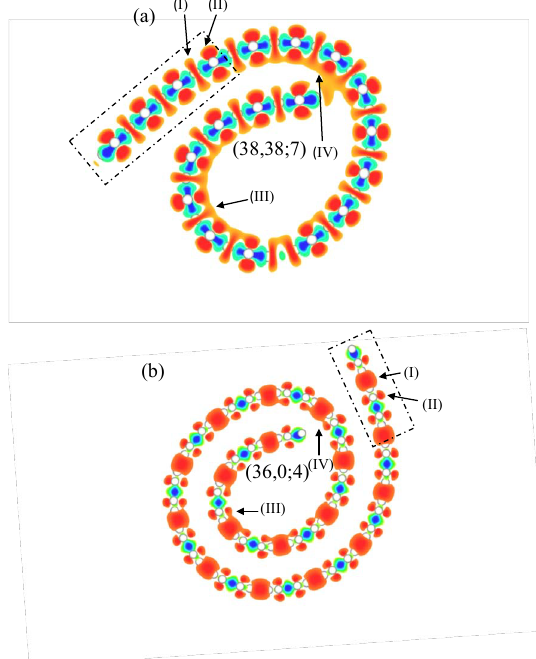
Figure 6. The charge distribution for ( a ) armchair (38,38;7) CNS; ( b ) zigzag (36,0;4) CNS. (II) are the 2 pz orbitals and (I) are the other three orbitals. (III) and (IV) are the serious orbital